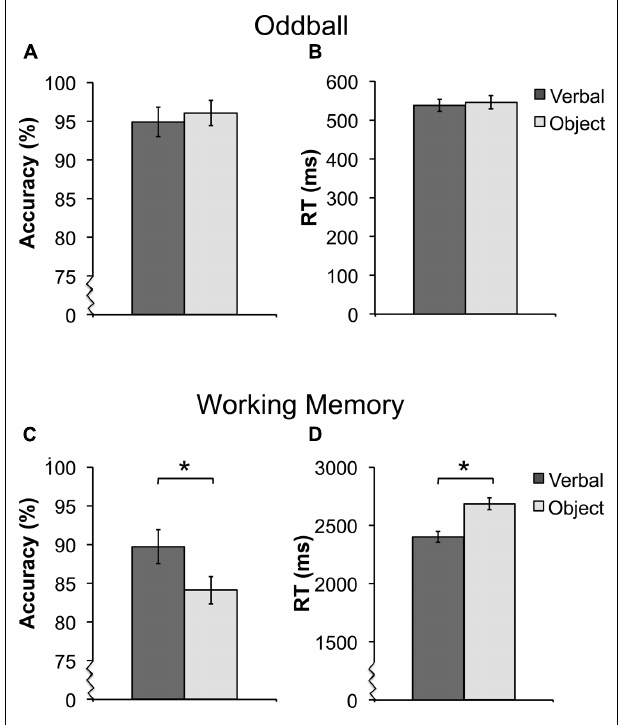
FIGURE 2 |Average accuracy and reaction time (RT) for the oddball [(A,B) ± SEM] and working memory [WM; (C,D) ± SEM] task. For the oddball task, there were no differences in detecting verbal or object targets in accuracy (A) or RT (B) . For theWM task, participants had both higher performance (C) and faster RT (D) for verbal trials. *Asterisks indicate a significant difference between the verbal and object trials of theWM task at p < 0.05. For better visualization of the differences in accuracy and RT, the y-axis starts a higher value in (A,C,D) , this is represented by the jagged line in these